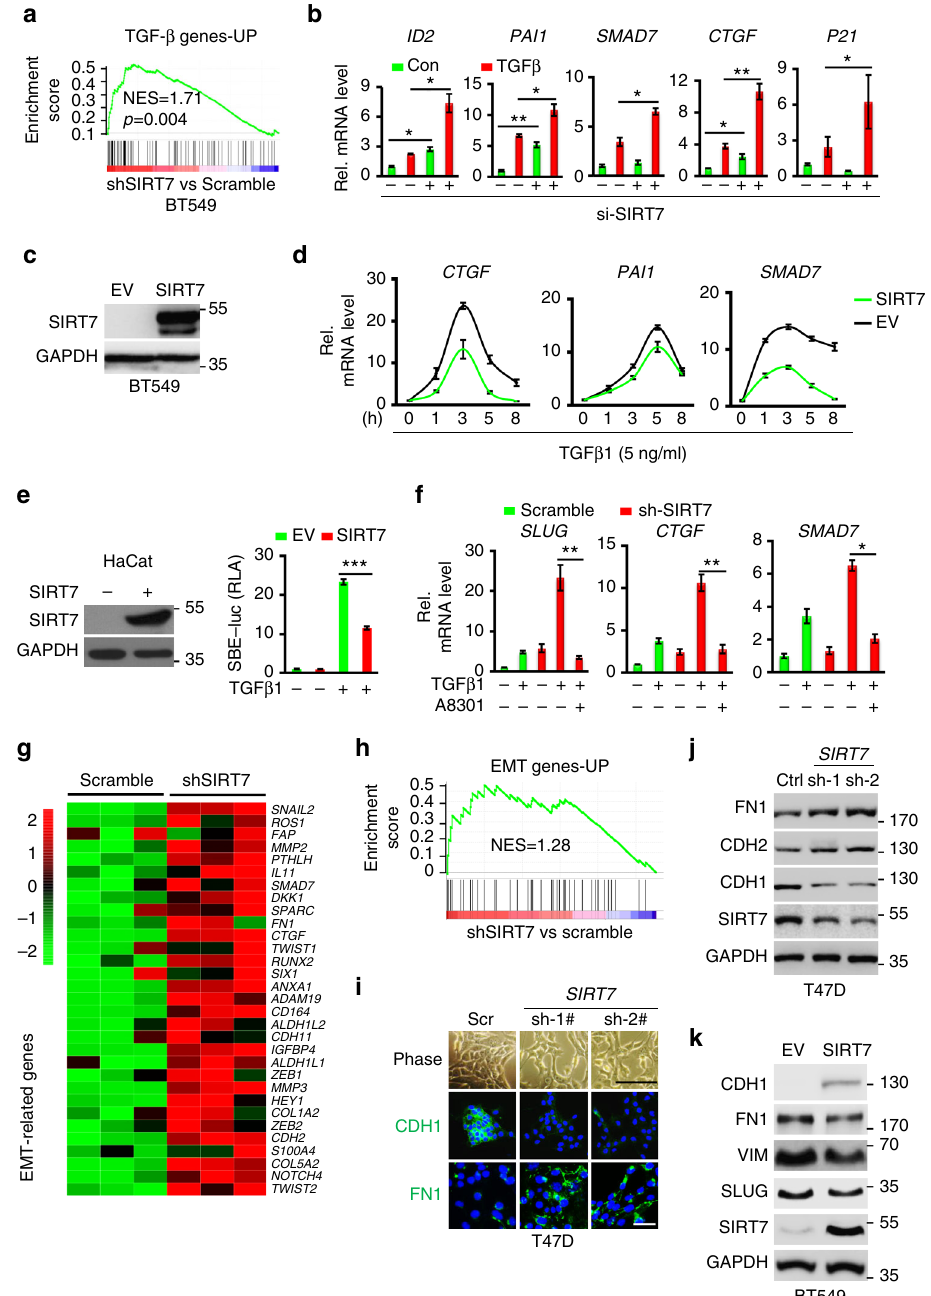
Fig. 3 Loss of SIRT7 activates TGF- β signaling and promotes EMT. a Gene set enrichment analysis (GSEA) showing the enrichment of TGF- β signaling gene signatures 69 in SIRT7 KD BT549 cells (shSIRT7) compared with Scramble control. b Quantitative RT-PCR analysis of TGF- β downstream gene ID2 , PAI1 , SMAD7 , CTGF , and P21 in SIRT7 KD BT549 cells in the presence or absence of TGF- β 1 (5 ng/ml, 2 h). c Representative immunoblots showing ectopic SIRT7 expression in BT549 cells. d Quantitative RT-PCR analysis of TGF- β signaling downstream gene CTGF , PAI1 , and SMAD7 at indicated time points in BT549 cells expressing ectopic SIRT7. e Relative luciferase activity (RLA) driven by SBE4-luc in control and SIRT7-overexpressing HaCaT cells. f Quantitative RT-PCR analysis of TGF- β downstream gene SLUG , SMAD7 , CTGF levels in cells treated with TGF β 1 (5 ng/ml) or TGF β R1 inhibitor A8301 (5 µ M). g Heatmap representation of RNA-Seq data showing expression levels of EMT-related genes 69 in Scramble and SIRT7 KD BT549 cells. h GSEA showing the enrichment of EMT-related gene signatures 70 in SIRT7 KD cells. i Phase contrast and immuno fl uorescence images showing epithelial marker CDH1 (E-cadherin) and mesenchymal marker Fibronectin 1 ( FN1 ) in Scramble and SIRT7 KD T47D cells. Scale bar , 100 µ m ( bright fi eld ) and 50 µ m (IF). j Immunoblots of SIRT7 and various EMT markers in T47D cells treated with Scramble (Ctrl) or SIRT7 shRNAs. k Immunoblots of SIRT7 and various EMT markers in BT549 cells expressing SIRT7 or empty vector control ( EV ). * P < 0.05, ** P < 0.01, *** P < 0.001. P -values are calculated by Student ’ s t -test. Data are shown as mean ± S.E.M. NES : normalized enrichment